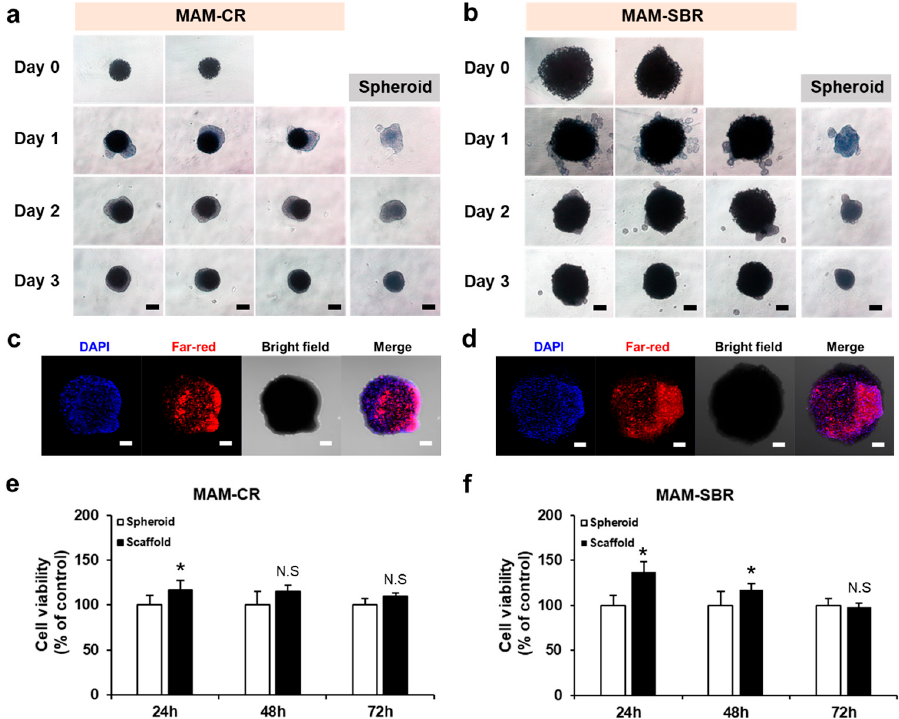
Figure 3. Cell loading and viability on the magnetic microscaffolds. Optical microscopy images of the cell-loaded ( a ) MAM-CR and ( b ) MAM-SBR for 3 days. The scale bars are 200 µ m. Fluorescence images of the cell-loaded ( c ) MAM-CR and ( d ) MAM-SBR after 1 day of incubation. The scale bars are 100 µ m. Cell viabilities of the ( e ) MAM-CR and ( f ) MAM-SBR measured for 3 days ( n = 3, * p < 0.05, Student’s t test). N.S, not significant.